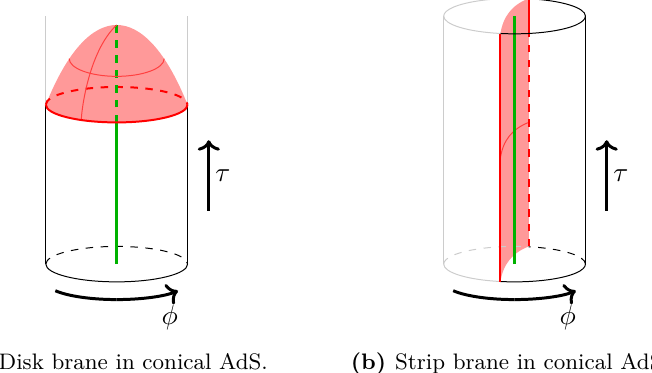
Figure 4. (a) A disk brane and (b) a strip brane in conical AdS. The conical defect at r = 0 is represented by the green line. The disk brane is a φ -symmetric slice of the bulk, while the strip brane is a τ -symmetric slice of the